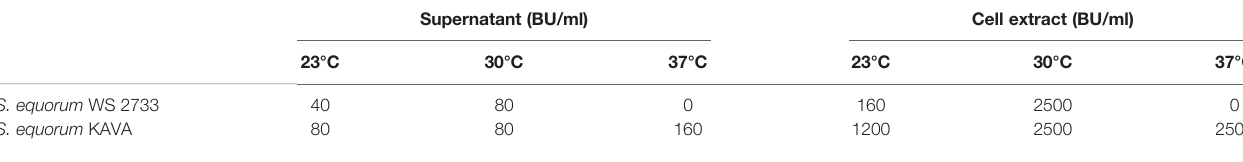
TABLE 3 | Comparison of MP1 production (in BU/ml) by S. equorum KAVA and S. equorum WS 2733 at different temperatures.